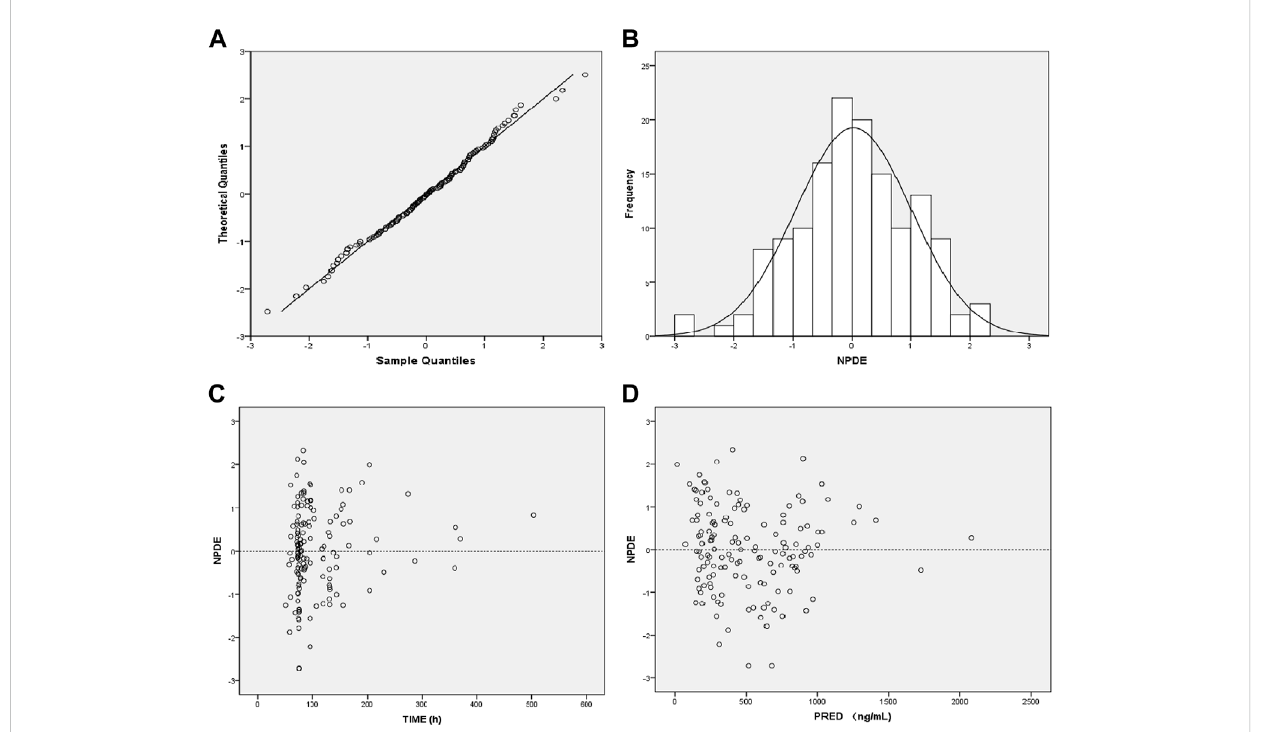
FIGURE 3 Diagnostic plot of the normalized prediction distribution error (NPDE) of the fi nal model. (A) Q-Q plot of NPDE, (B) distribution histogram of NPDE, (C) Scatter plot of NPDE-TIME, (D) Scatter plot of NPDE-Population Predicted Values.